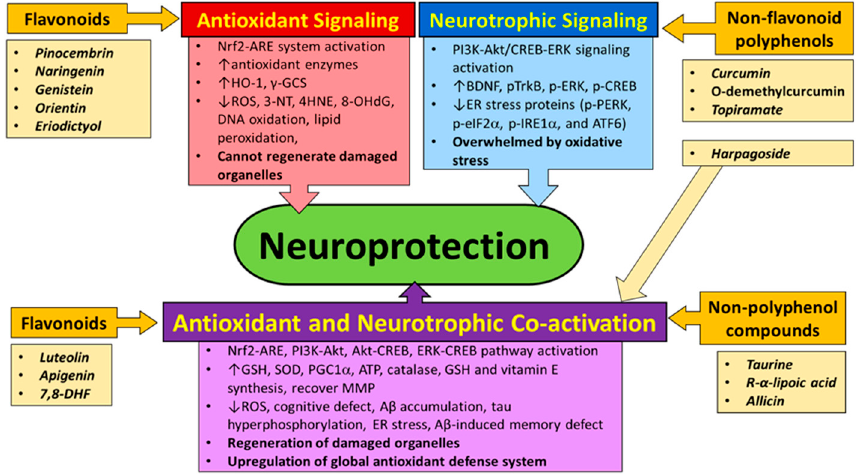
Figure 3. A better way to slow AD: Co-activation of the Nrf2-ARE antioxidant system and neurotrophic signaling pathway. In AD, A β peptides and oxidative stress increase ROS, attack mitochondrial integrity and overpower antioxidant system. This leads to generation of lipid peroxides, DNA, protein and organelle damage, synaptic defects, increased ER stress response, and ultimately neuron death. In order to mitigate oxidative stress in AD brains, global antioxidant defense system should be upregulated. The activation of the Nrf2-ARE antioxidant defense system has been seen via FGFs and certain flavonoids. However, unilateral activation of the antioxidant system is insufficient in altering AD progression. Activation of neurotrophic signaling pathway is also necessary for regeneration of damaged organelles, which has been evidenced in various non-flavonoid polyphenols. Synergistic co-activation of the Nrf2-ARE system and neurotrophic signaling pathway, however, may provide a greater ameliorating effect on AD pathogenesis. Co-activation of these pathways can be achieved by either a combination of the Nrf2-ARE activator and neurotrophic signaling activator or a multimodal activator such as luteolin, apigenin, 7,8-DHF, harpagoside, taurine, and R - α -lipoic acid. Either combinatory treatment or strong multimodal-effect agent will have a greater ability of ameliorating or modifying the progression of multifaceted AD by co-activating antioxidant and neurotophic signaling pathways. ( ↑ : increase; ↓ : decrease).